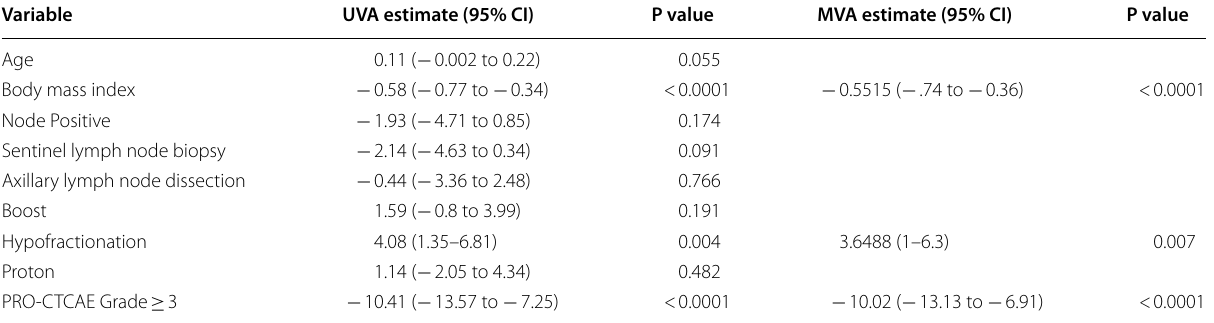
CI, confidence interval